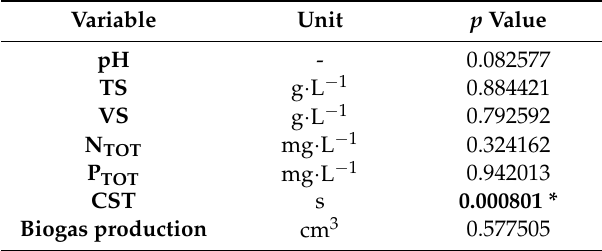
Table A8. The results of ANOVA Test—technological